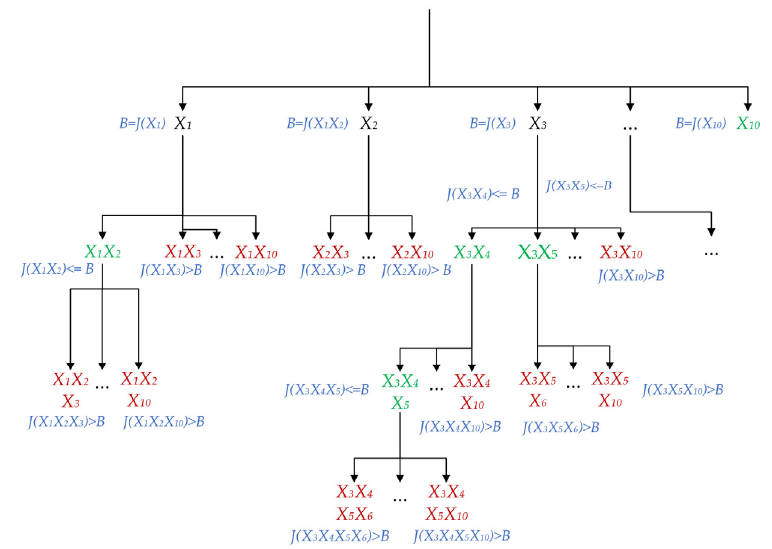
Figure 11. Search tree grouping expansion